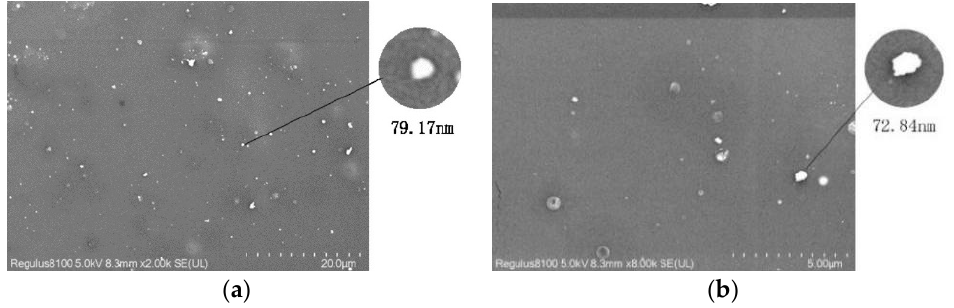
Figure 12. Dispersion size of zeolite in PLA/zeolite-2 magnified 2000 times ( a ) and 8000 times ( b ). Tensile samples were cut along the blown direction of the film. The longitudinal tensile strength and elongation are shown in Figure